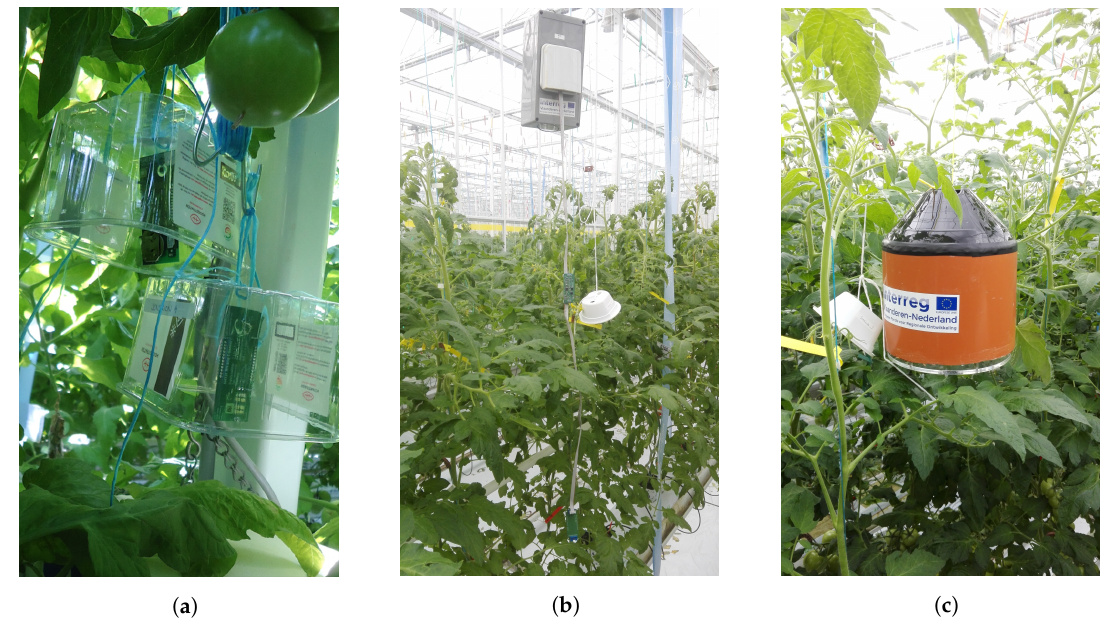
Figure 4. Different types of boxes used for deployment: ( a ) Sensirion sensors protected by strawberry box; ( b ) Rectangular box casing; and ( c ) airflow box casing.